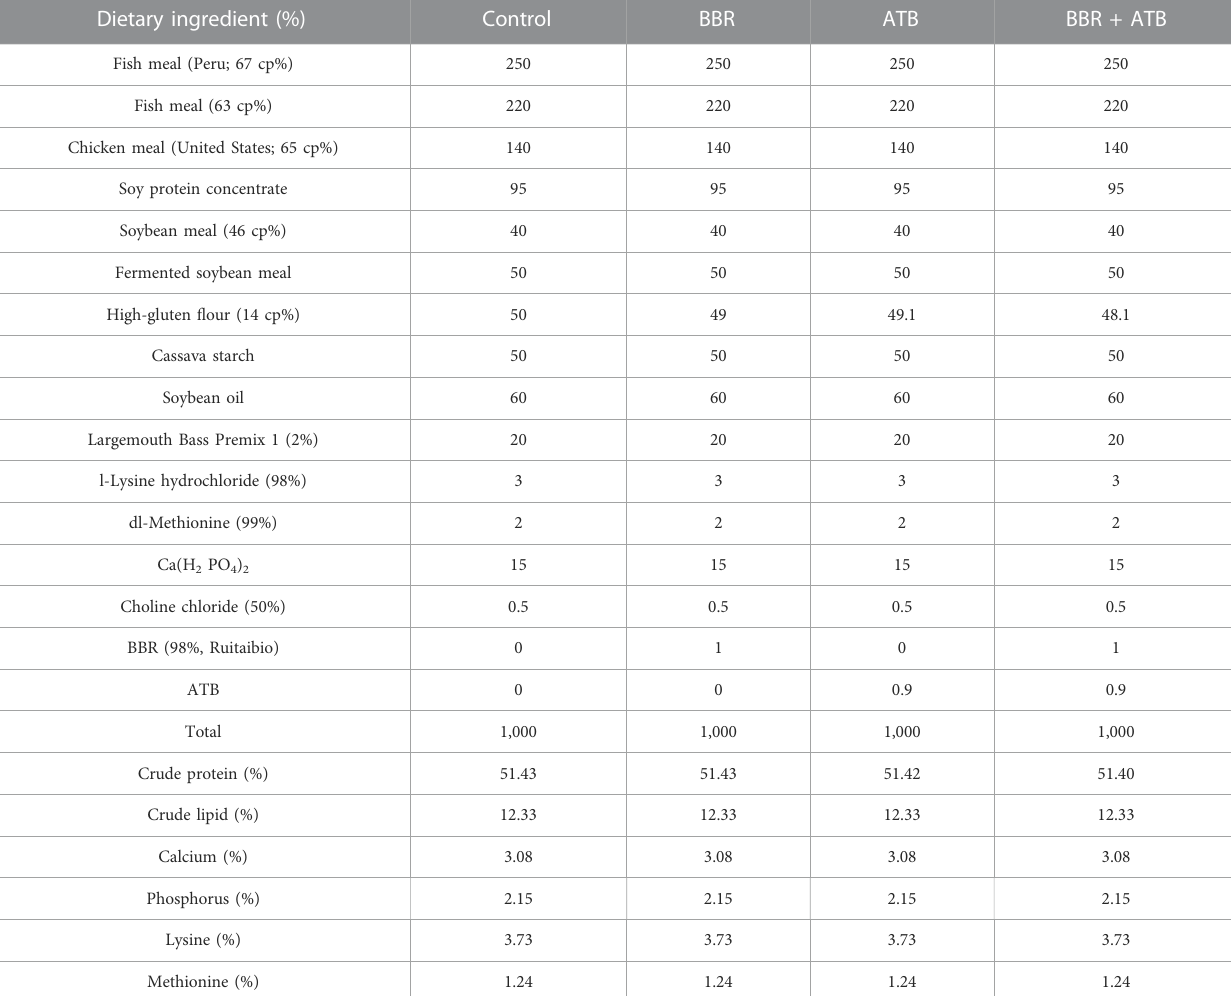
TABLE 1 Ingredient and proximate composition of experimental diets (g). Dietary ingredient